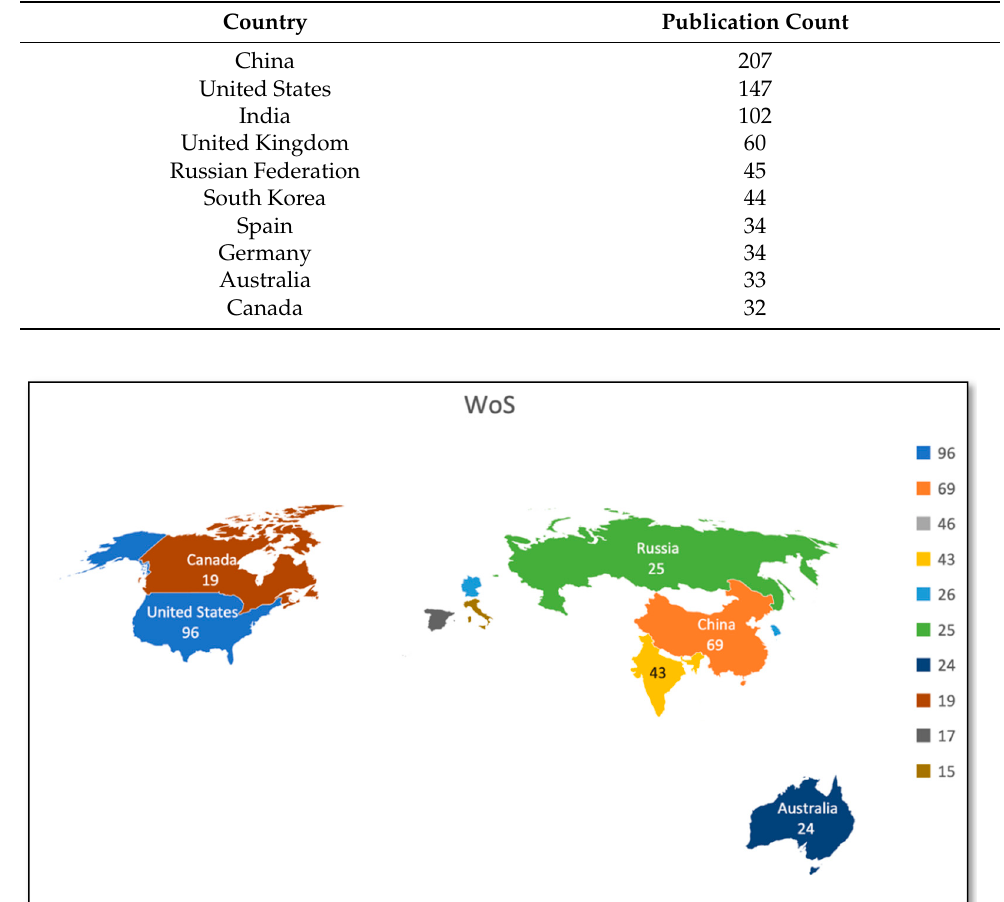
Figure 10. Publications by geographical area (WoS core collection). Table 8. Publication count by geographical area (WoS core collection).